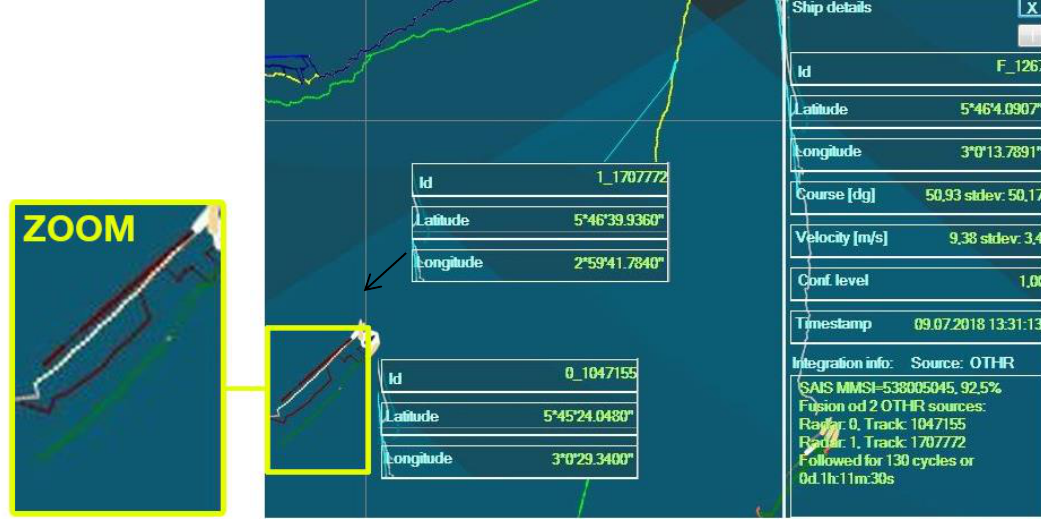
Figure 10. Example of multi-sensor integration (green trace: radar 0 data, red trace: radar 1 data, brown trace: fused track, white trace: Automatic Identification System (AIS) data).